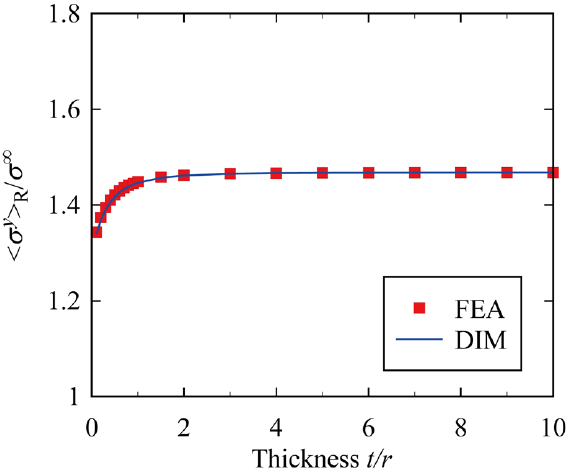
Figure 8. Macroscopic average normal stress of R phase with various thicknesses of the Γ phase. The (cid:11) stress (cid:104) σ y R is normalized by the remote stress σ 𝑦𝑦